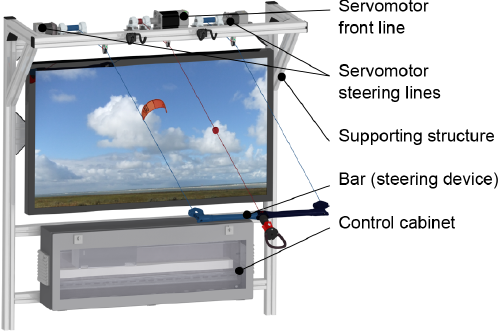
Figure 10. Design of the user interface (bar